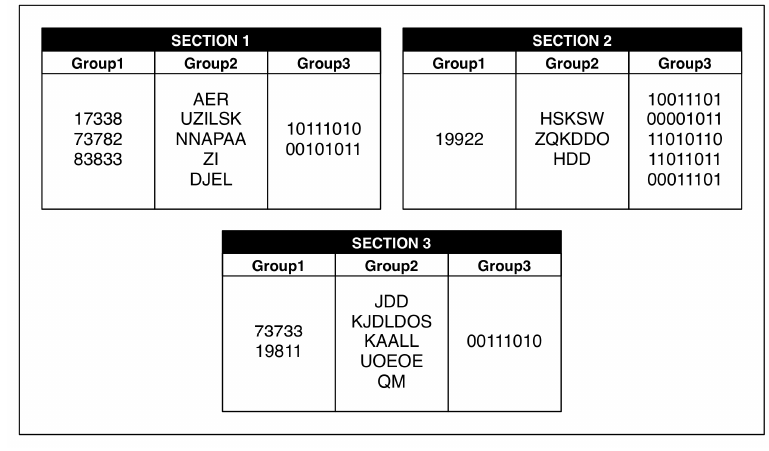
Figure 1: Example of a structured bulletin board with three sections, three groups, corresponding types, and some